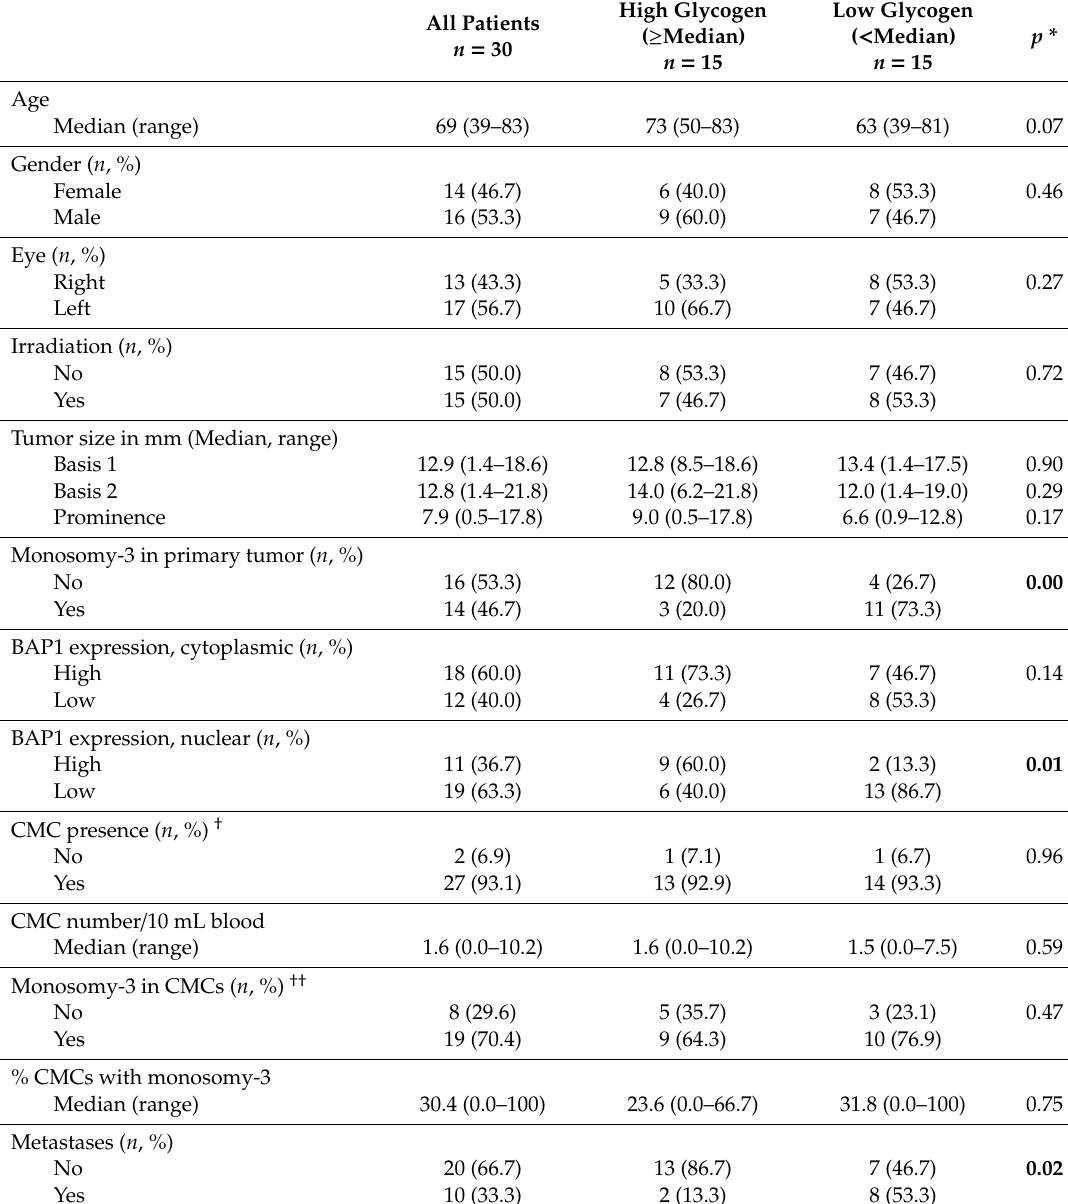
Table 2. Association of the glycogen levels with the histopathological and clinical factors (follow-up time: 2–9